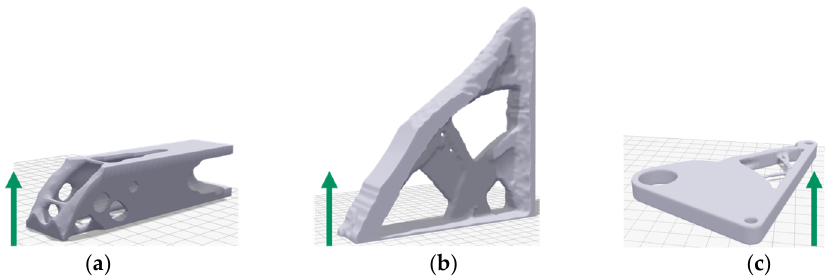
green denote passive regions, if applicable.